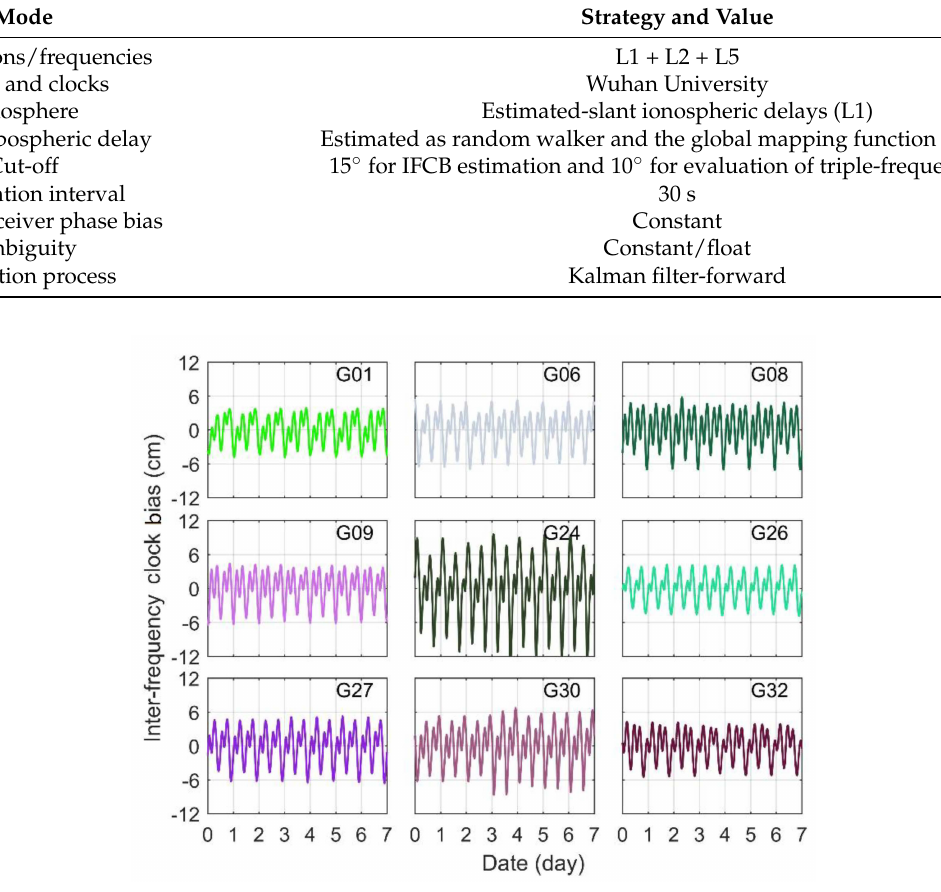
Figure 2. IFCB time series of the Block IIF